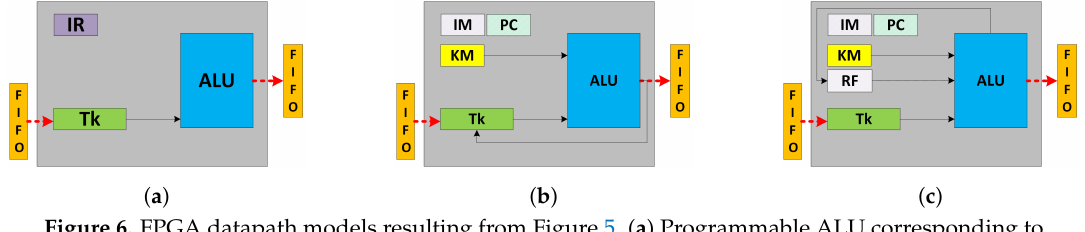
Figure 6. FPGA datapath models resulting from Figure 5. ( a ) Programmable ALU corresponding to configuration 1 (cid:13) ; ( b ) Fine-grained processor corresponding to configuration 2 (cid:13) ; ( c ) Coarse-grained processor corresponding to configuration 3 (cid:13)